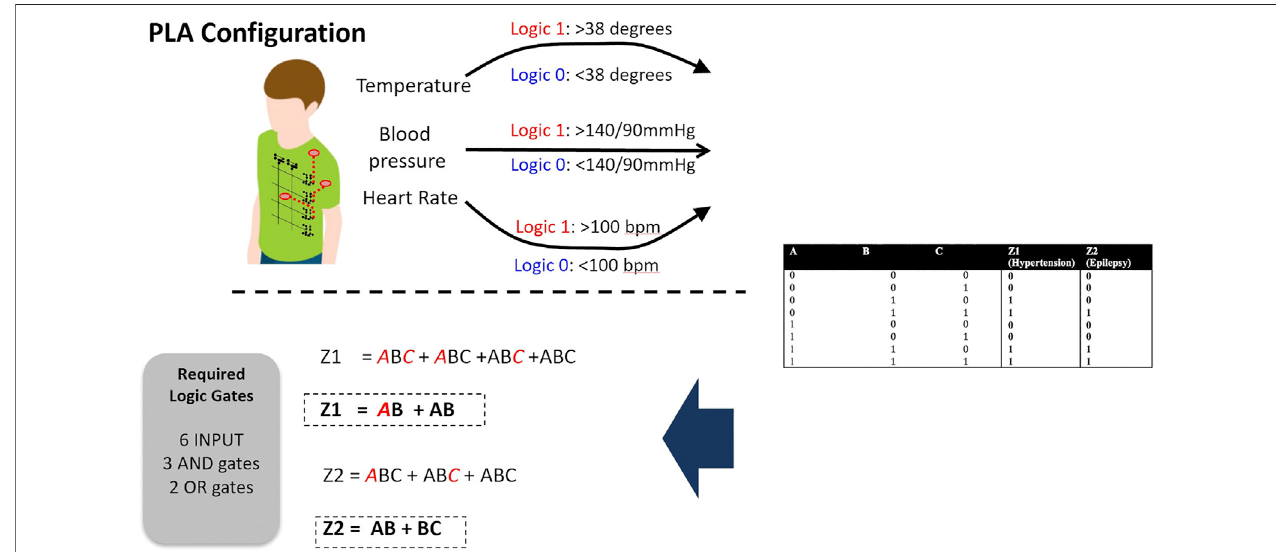
FIGURE 1 | PLA con fi guration, de fi nition of the truth table, and Boolean expression.